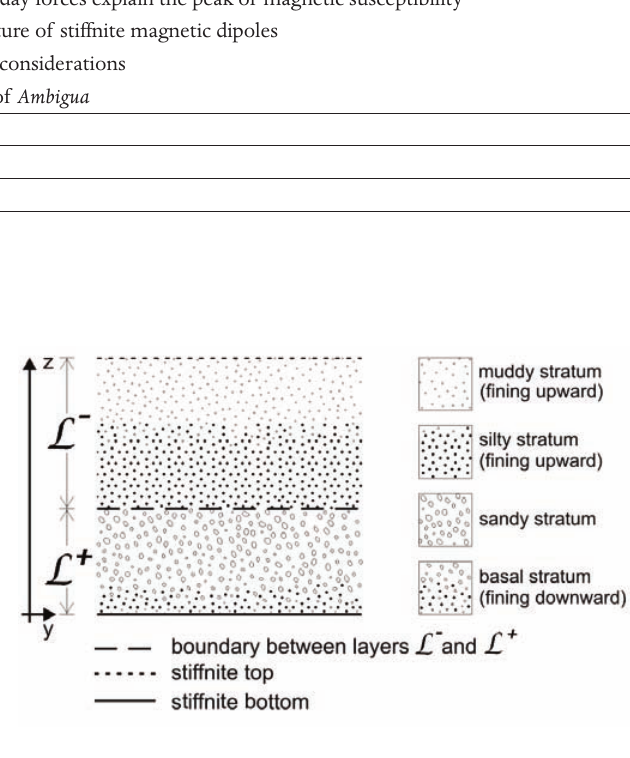
Figure 1. Illustration of a stiffnite deposit. The relative thicknesses of the various muddy, silty strata are not to scale. Sheet L – is characterized by ‘small’ particles fining upwards. This overlies sheet L + , which is dominated by sandy particles. In the basal portion of sheet L + , there is a possible downwards fining of the grains. Large and small particles are identified in accordance to a radius R , defined in the main text. In a flowing stiffnite, sheets L + and L – th have net positive and negative charge densities, respectively; they are neutral in an old stiffnite deposit at rest. Microshell fragments occur in the